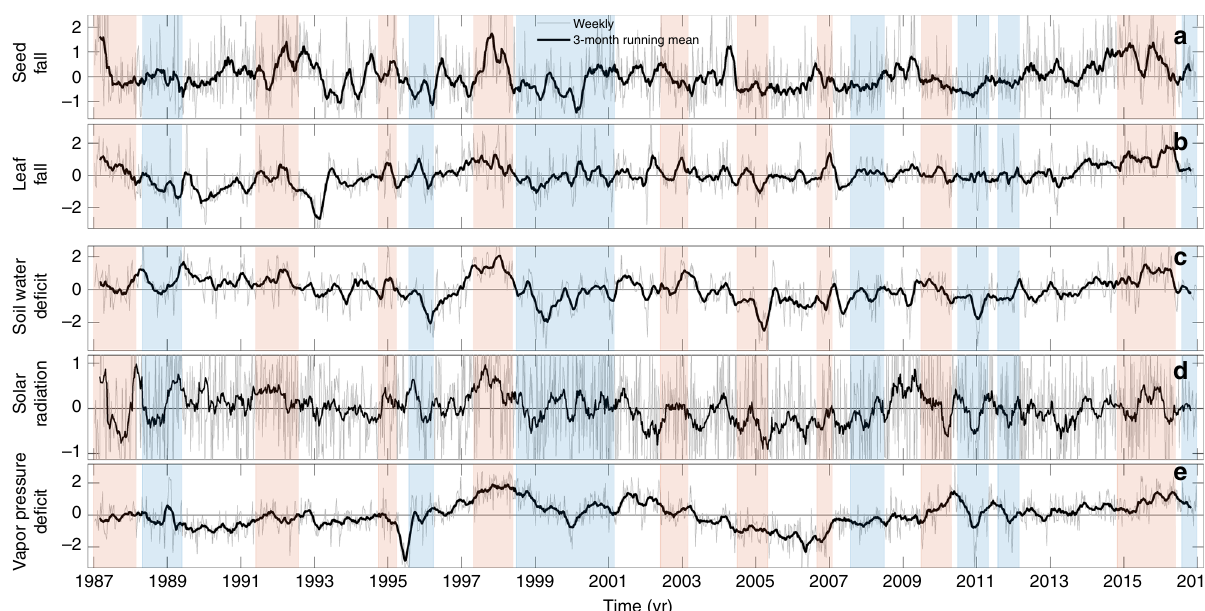
Fig. 1 Temporal variation of phenological and climate variables. Weekly series of a seed fall (200 traps, 250 species), b leaf fall (59 traps, 397 species), and c , d , e climate variables measured in the tropical forest on Barro Colorado Island between 1987 and 2016 in relation to El Niño events (red shading) and La Niña events (blue). All series are seasonally detrended and normalized to zero mean and unit variance to facilitate visual comparison. The dark lines show 3-month running means; the thin gray lines show the weekly time series. X -axis ticks indicate January 1st. El Niño and La Niña events are identi fi ed based on Oceanic Niño Index values >0.5 °C and less than − 0.5 °C, respectively, for at least fi ve consecutive months. Note the major El Niño event in 1997 –